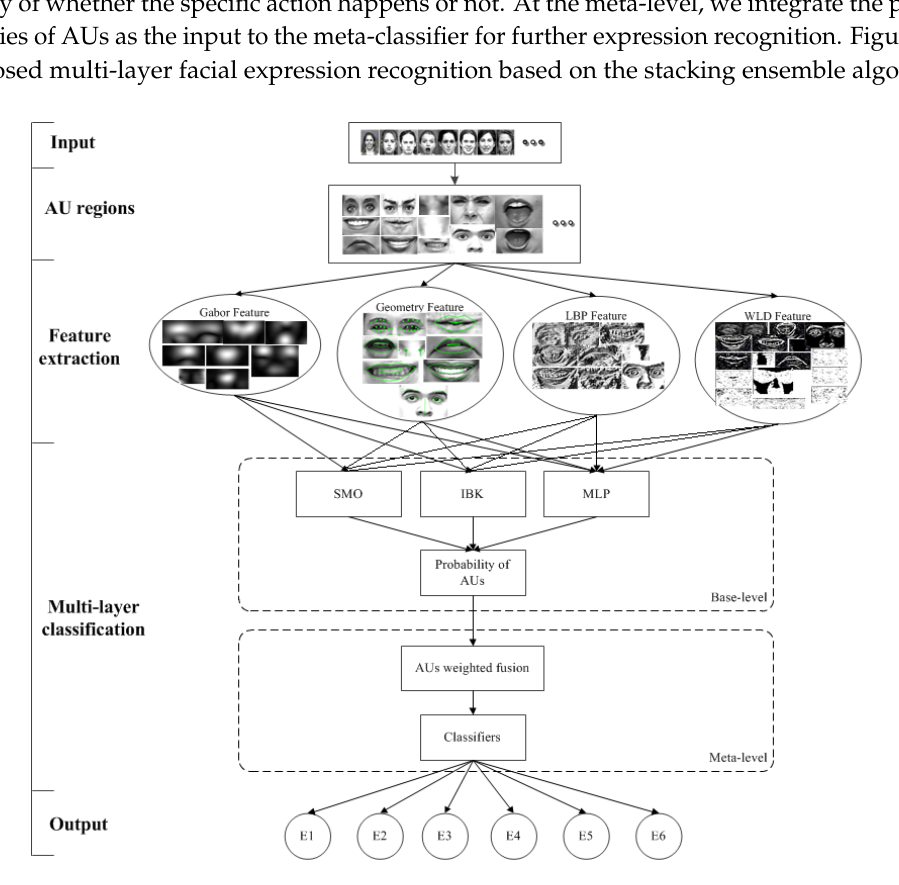
Figure 5. Multi-layer facial expression recognition based on the stacking ensemblestrategy.